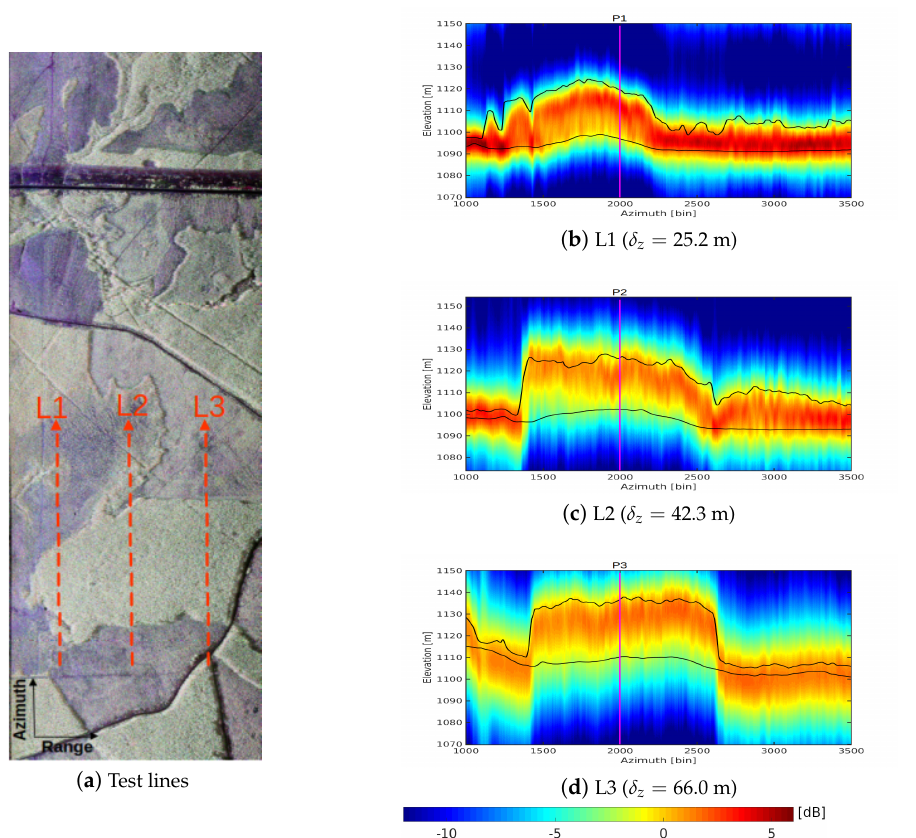
Figure 6. P-Capon tomograms for test lines located in near, mid and far range, respectively. The black line is the LiDAR ground and tree top elevation estimates.